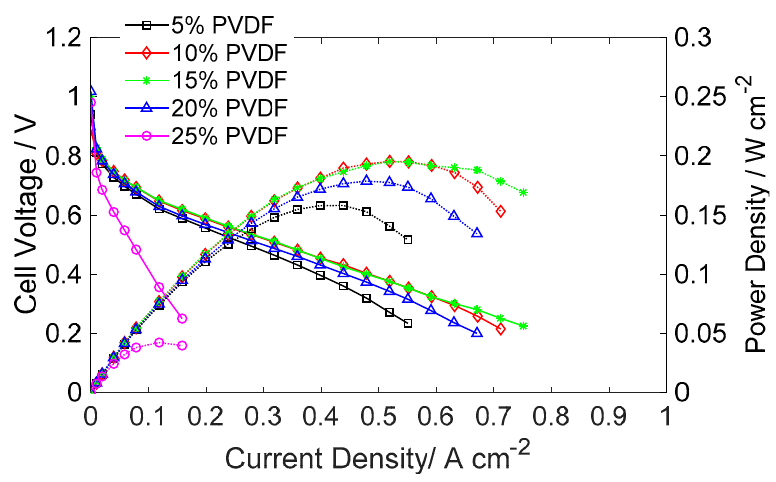
Figure 1. Polarization curves of the single cell with various PVDF loadings.